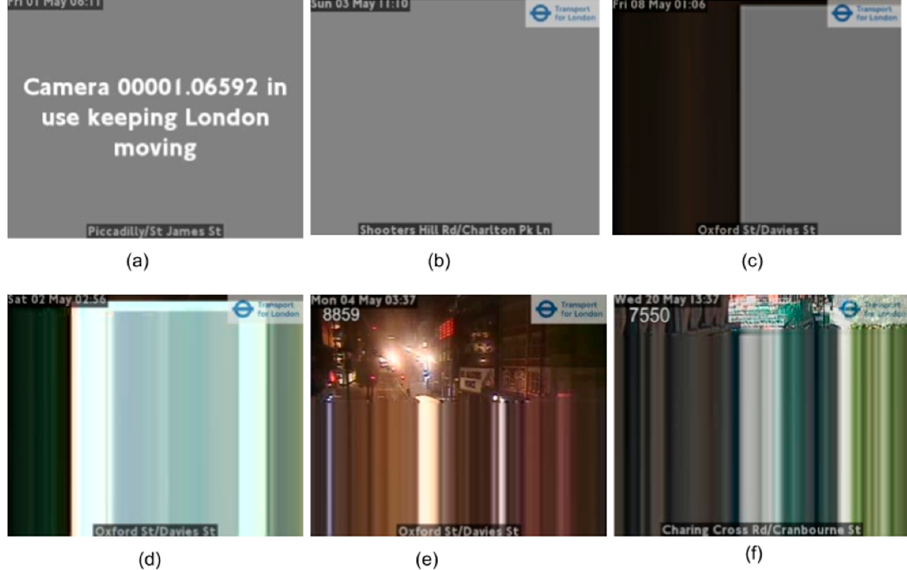
Figure 7. Examples of corrupt or problematic images. ( a ) Camera offline usually due to ongoing incident; ( b , c ) cameras offline; ( d – f ) examples of distorted images (images TfL Open Data).